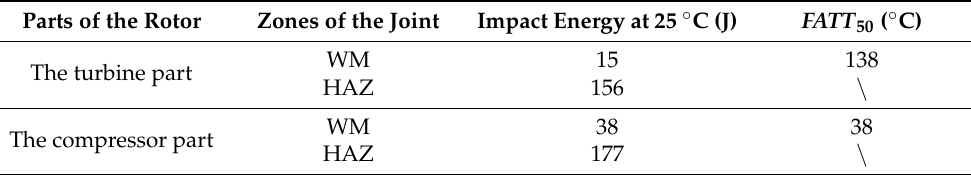
Impact energy and FATT 50 of the WMs and HAZs in the turbine part and the compressor part. Parts of the Rotor Zones of the Joint Impact Energy at 25 ◦ C (J) FATT 50 ( ◦ C) WM 15 138 The turbine part HAZ 156 \ The compressor part